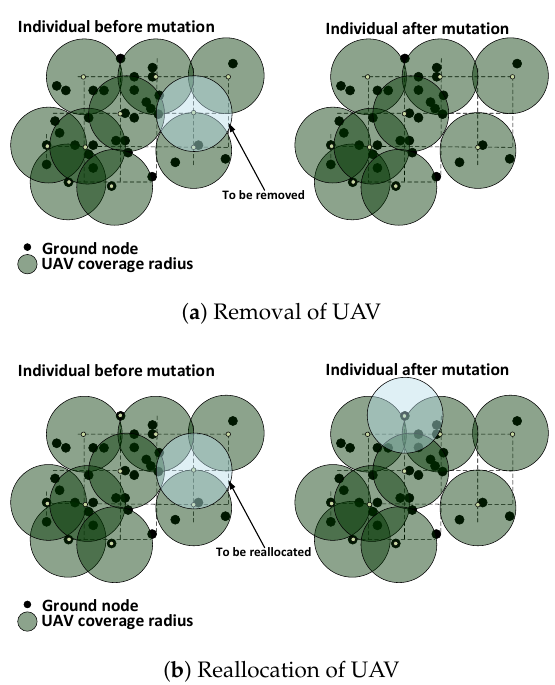
Figure 5. UAV removal and reallocation procedures during